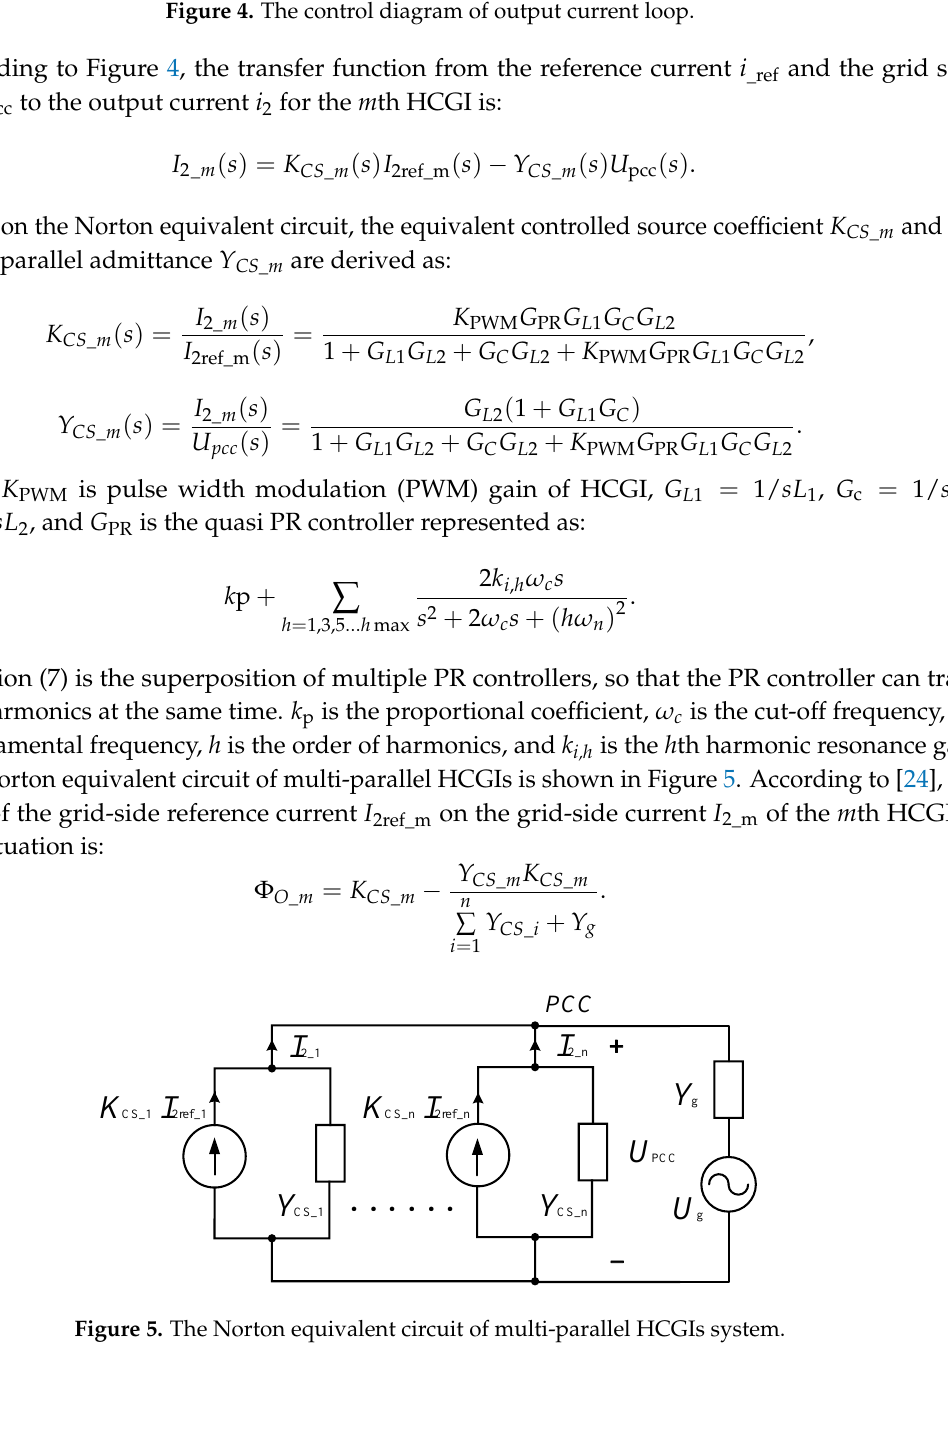
Figure 4. The control diagram of output current loop.